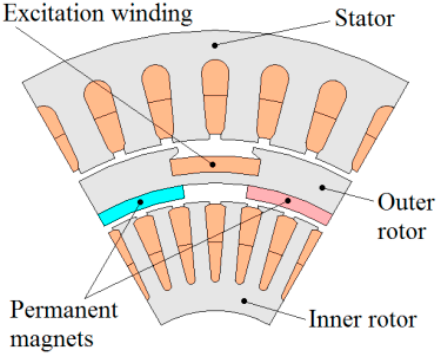
Math. Comput. Appl. 2019 , 24 , x FOR PEER Figure 6. Electrical variable transmission with hybrid excitation [32,33]. Figure 6. Electrical variable transmission with hybrid excitation [32,33].